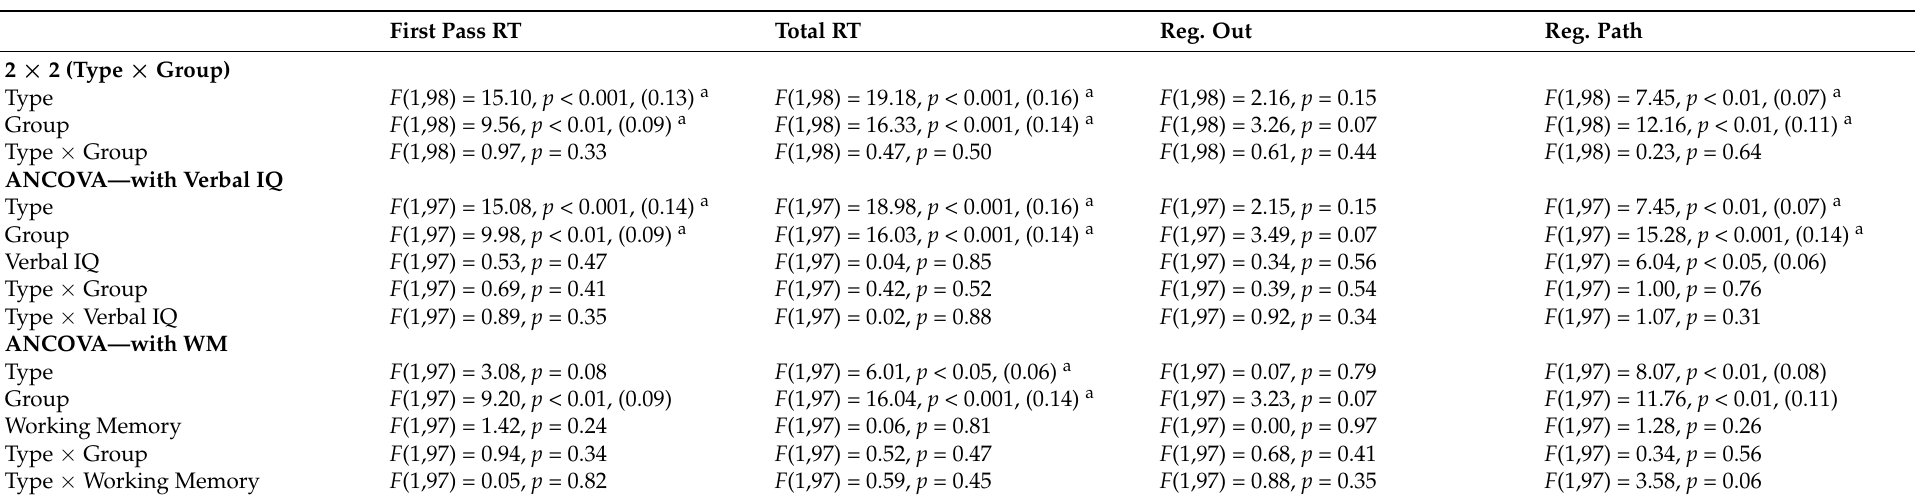
Table 6. Mixed ANCOVA analysis for eye movement measures for the relative